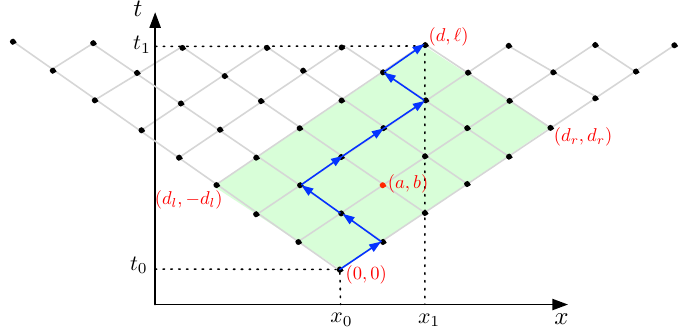
Figure 3. The random walk grid network on the bottom cone with the one-dimensional prism in green. Random walks move from level to level between the black points following the grey line segments. The coordinates in red are in the local coordinate system. The blue arrows give an example random walk path from the first to the second anchor